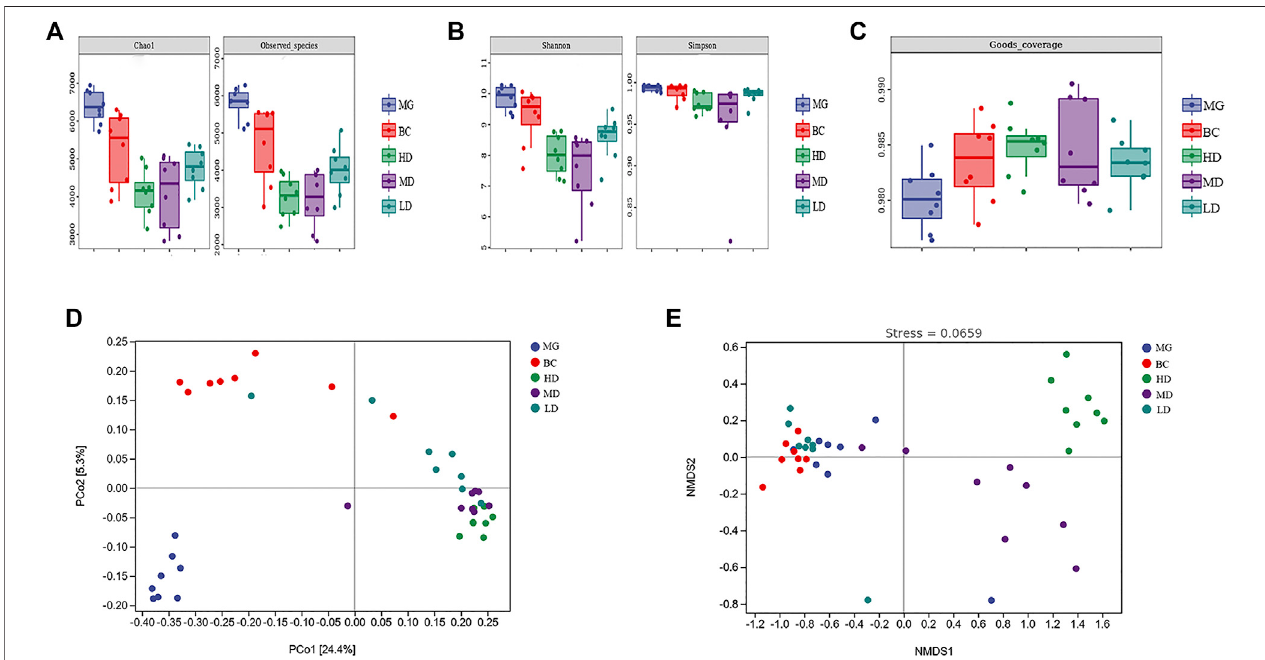
FIGURE 5 | Species diversity. (A) Chao1 Index and Observed Species Index. (B) Shannon Index and Simpson Diversity Index (C) Good ’ s Coverage Index. PCoA (D) and NMDS (E) were applied on the basis of the unweighted UniFraq